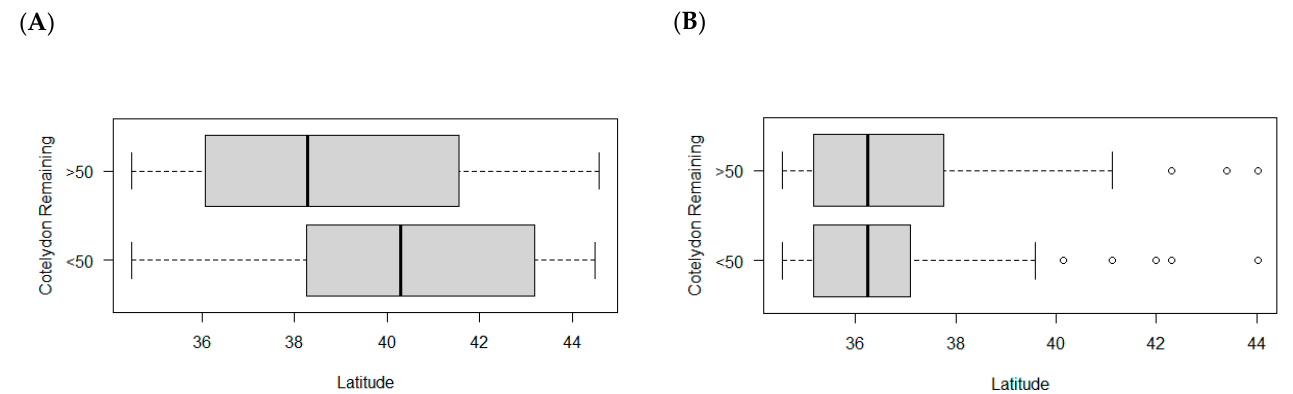
Figure 6. Patterns of cotyledon damage in acorns of ( A ) Q. rubra and ( B ) Q. alba across latitude. Shown are the box plots of latitude of acorns with either >50% of cotyledon remaining and the same for acorns with <50% of cotyledon remaining. Each acorn in this analysis had been infested with only one weevil as evidenced by one exit hole. Q. rubra acorns showed less damage in lower latitudes, however this difference was not significant ( p < 0.067). Q. alba showed no difference across latitude ( p = 0.112).